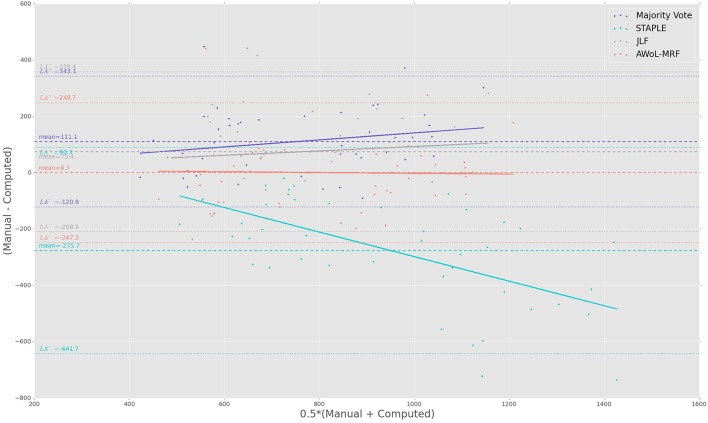
Experiment III Bland-Altman analysis: Comparison between computed and manual volumes (in mm3) for single parameter configuration of 9 atlases and 19 templates. The overall mean difference in volume, and limits of agreement (LA+/LA−: 1.96 SD) are shown by dashed horizontal lines. Linear fit lines are shown for each method. Note that the points above the mean difference indicate underestimation of the volume with respect to the manual volume, and vice versa.